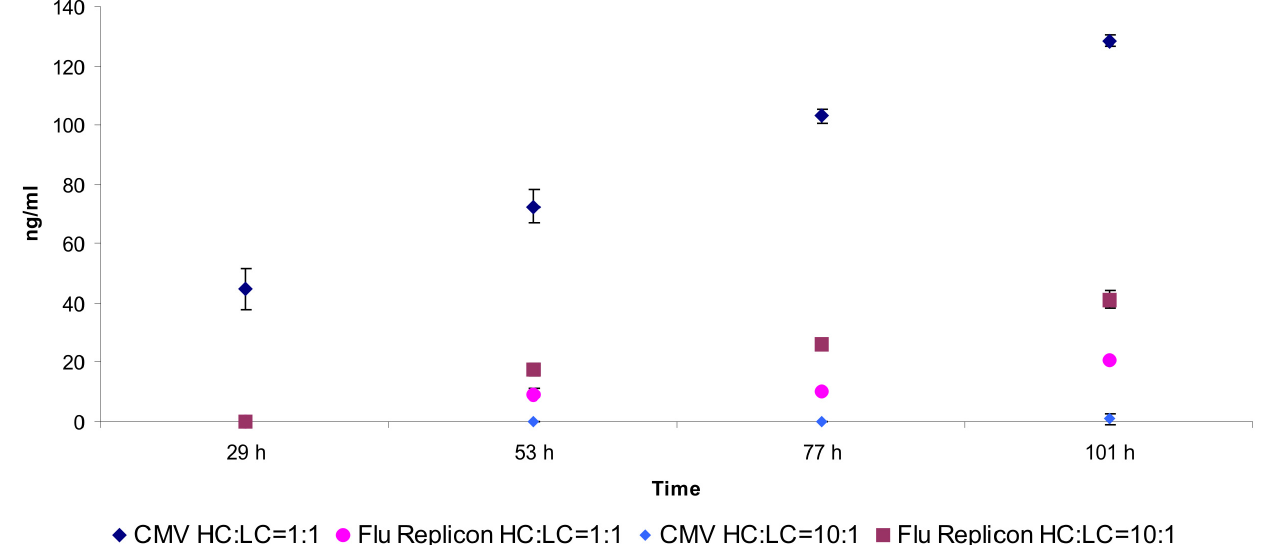
Figure 11. Expression of a the monoclonal anti-gp41 antibody 3D6. HEK-293 cells were either tranfected with pRC-LC and pRC-HC (CMV HC:LC=1:1, CMV HC:LC=10:1) or with the influenza replicon and pMono-LC and pMono-HC (Flu Replicon HC:LC=1:1, Flu Replicon HC:LC=10:1). Heavy chain to light chain ratios of 1:1 and 10:1 were tested. Antibody concentration in the culture supernatant was monitored for 101 hours by ELISA. Data represents arithmetic mean values and standard deviation.